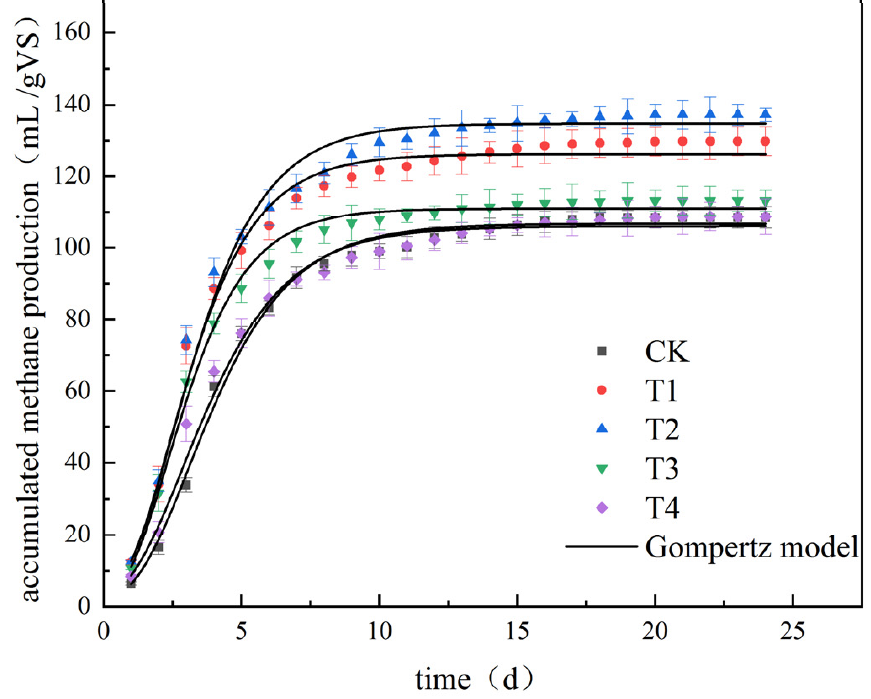
Figure 10. Effect of biogas slurry reflux on cumulative methane production during anaerobic diges- tion. 4. Discussion In order to solve the problem of pollution-free treatment and high-value utilization of biogas slurry, this study developed a quality improvement and efficiency utilization model for biogas slurry, which was recycled into an AD system through microfiltration membrane and biochar adsorption. The results showed that the retention effect of the mi- crofiltration membranes with a pore size of 0.65 μ m was the best, and the content of SS, COD, and ammonia nitrogen in the permeate obtained by S1 filtration was the lowest, at 81.23%, 44.19%, and 22.46% lower than that of CK, respectively. The contents of SS, COD, and ammonia nitrogen were reduced by adding biochar to the biogas retentate. The re- moval efficiency of COD was the most obvious and was 32.35% after adding 13 g/L bio- char. Compared with CK (without biogas slurry return), the gas production peak of the treatment groups with biogas slurry return was 1 day earlier, and the cumulative methane production and the maximum daily methane production were both increased. The modi- fied Gompertz model was used to fit the data (R2 > 0.98), indicating that the supernatant